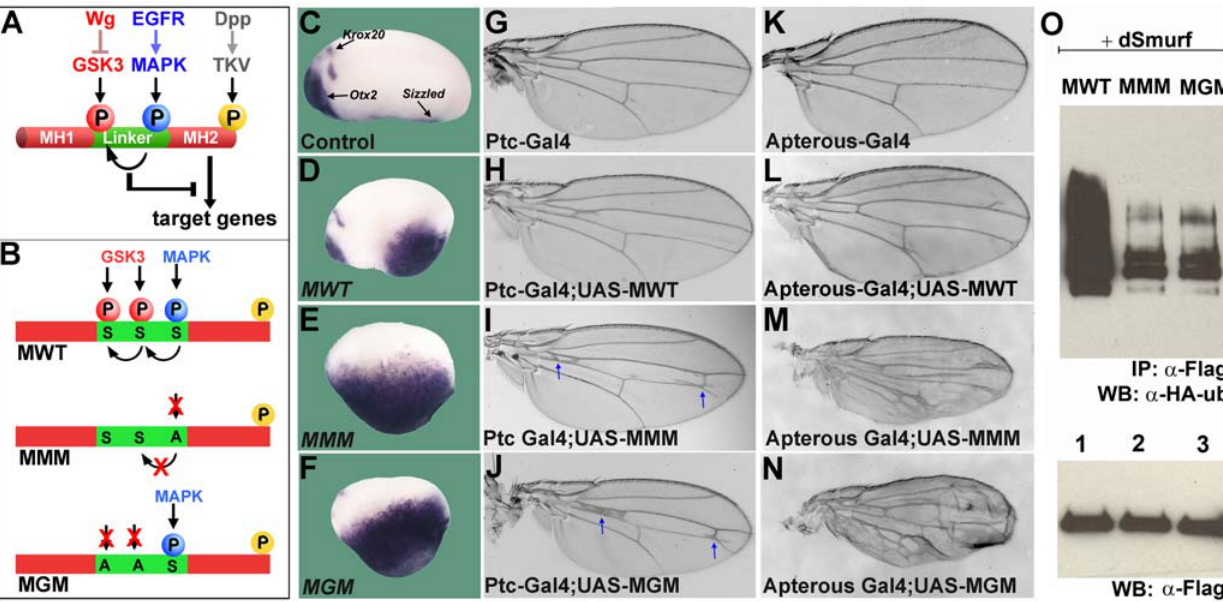
Figure 1. Phosphorylation-Resistant Mad Proteins are Hyperactive. (A) Model summarizing the integration of Dpp, EGFR and Wg signaling at the level of Mad phosphorylations in Drosophila . (B) Diagrams of Mad Wild Type (MWT), Mad MAPK Mutant (MMM) and Mad GSK3 Mutant (MGM) proteins. (C–F) Microinjection of MMM and MGM mRNAs into Xenopus embryos had stronger ventralizing activity than MWT, causing upregulation of sizzled (n=17, 32, 26, and 30, two independent experiments). Brain markers o tx2 and krox20 were repressed. (G–J) Driving MMM and MGM with patched-Gal4 in the anterior wing compartment caused formation of ectopic crossvein-like tissue. This tissue links longitudinal veins two and three in both proximal and distal regions, pulling the two veins closer together. (K–N) Driving phosphorylation-resistant Mads with apterous-Gal4 induced ectopic vein tissue and blistering, indicating increased Dpp signaling. (O) Polyubiquitinylation of Mad requires GSK3 and MAPK phosphorylation sites. Lane 1, 293T cells cotransfected with MWT-Flag, Drosophila Smurf and HA-ubiquitin all cloned in pCS2. The strong smear represents polyubiquitinylated Mad tagged with HA-ubiquitin. Lanes 2 and 3, polyubiquitinylation was greatly decreased in the MMM and MGM mutant proteins. The lower panel shows equal levels of immunoprecipitated Mad ( a